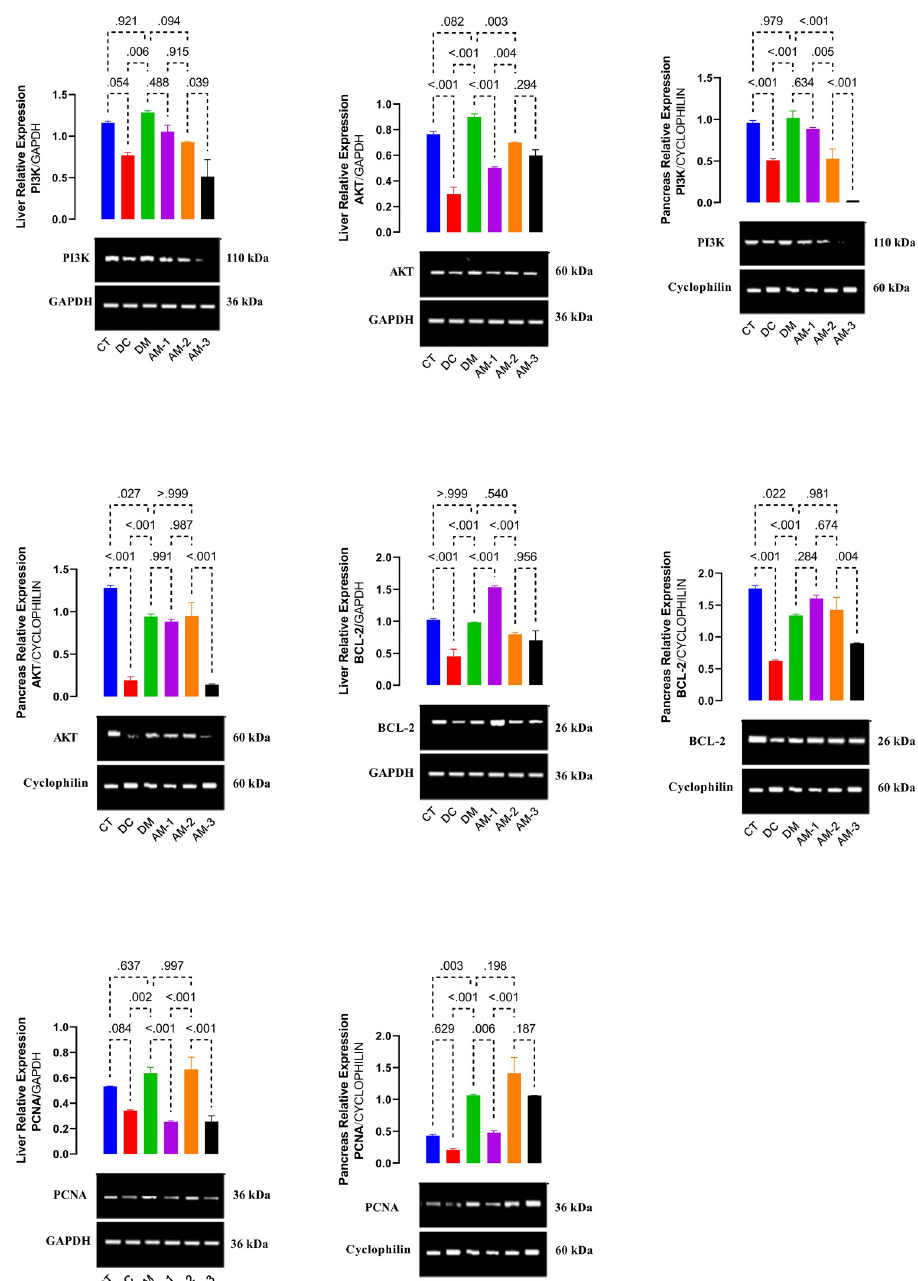
Fig 4. Effect of AEAMP on PI3K, AKT, Bcl2, and PCNA in liver and pancreas of diabetic rats examined by RT-PCR. GAPDH and cyclophilin were used as loading control for liver and pancreas PI3K/ATK, Bcl2, and PCNA. Data are expressed as mean ± SD (n = 6); AEAMP: aqueous extract of A. muricata peels; PCNA: proliferating cell nuclear antigen; CT: control group; DC: Diabetic control; DM: Diabetic metformin; AM-1: Diabetic + AEAMP (6.76 mg/kg); AM-2: Diabetic + AEAMP (13.53 mg/kg); AM-3: Diabetic + AEAMP (27.06 mg/kg).